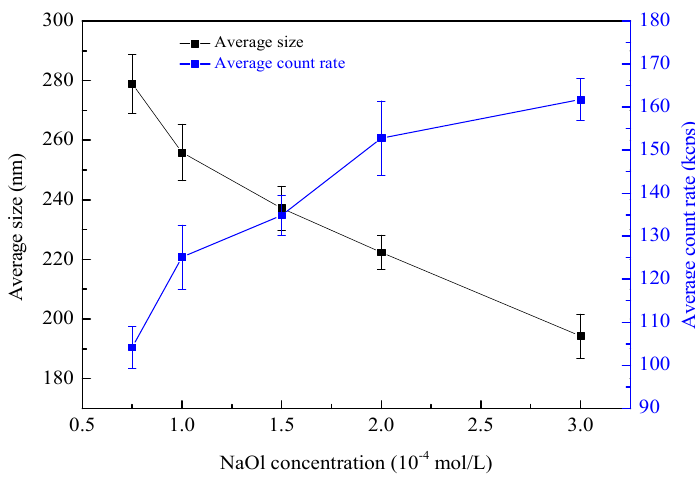
Figure 4. Properties of nanobubbles (NBs) generated by HC.